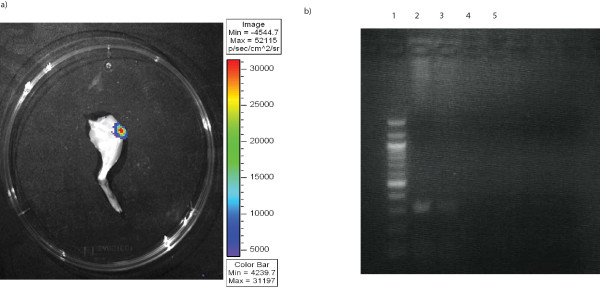
Electroporation mediate plasmid transfection of quadriceps. a) In vivo muscle transfection by EP was assessed by luciferase activity in resected leg 72 h post transfection (imaged for 1 min using an intensified CCD camera (IVIS Imaging System, Xenogen). b) RT-PCR analysis of mRNA expression of hPSA in muscle. hPSA was only detected in muscles electroporated with phPSA (lane 1 100 bp marker, lane 2 phPSA transfected muscle (sample a), lane 3 phPSA transfected muscle (sample b), lane 4 empty vector transfected muscle, lane 5 untreated muscle).